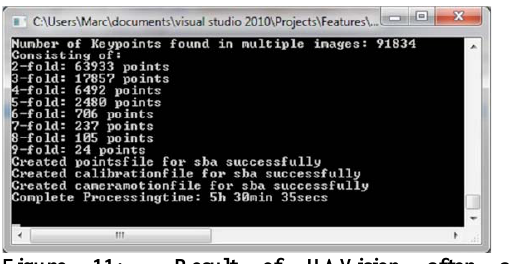
Figure 11: Result of UAVision after applying MultiUAVMatcher and preparing for bundle